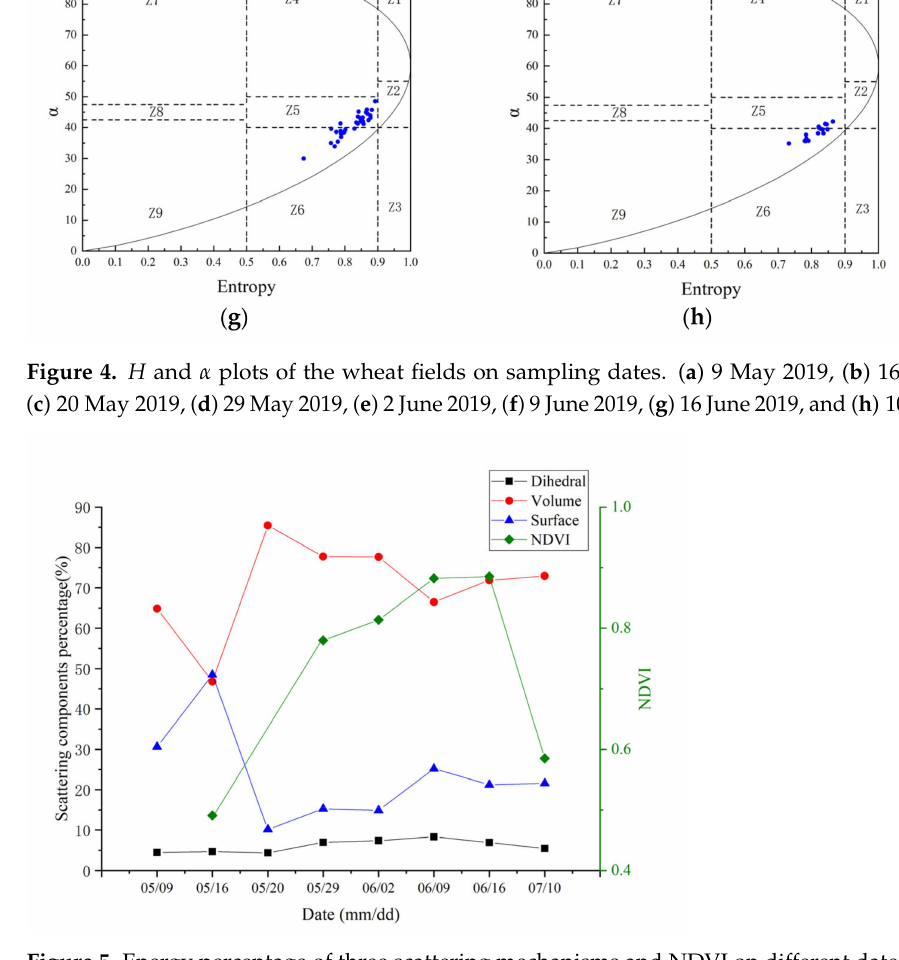
Figure 5. Energy percentage of three scattering mechanisms and NDVI on different